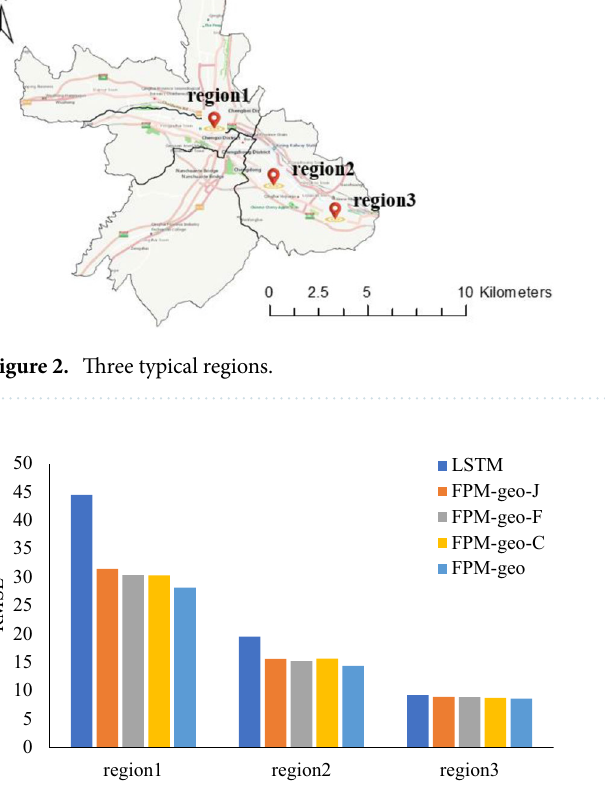
Figure 3. RMSEs of typical regions with different considered spatial relationships.